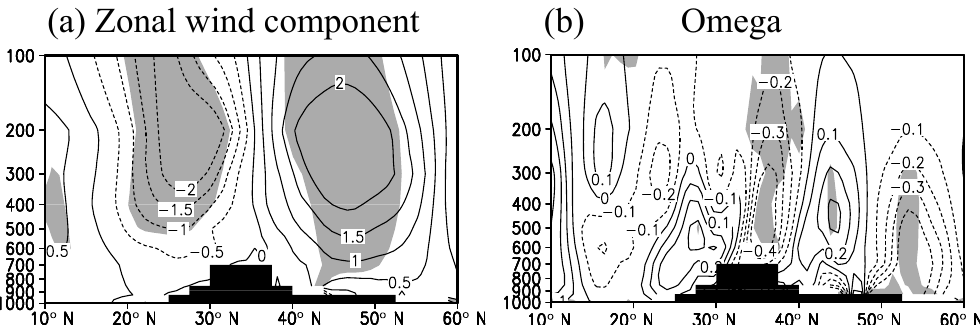
Figure 9. Changes in (a) the zonal wind component (ms − 1 ) and (b) the omega (0 . 01 × Pas − 1 ) in a vertical cross section at 75–115 ◦ E in MAM induced by the dust-in-snow radiative forcing. Here the grey shaded area represents the grid points where the changes pass the two-tailed t test at the 5% significance level. The black area indicates the plateau